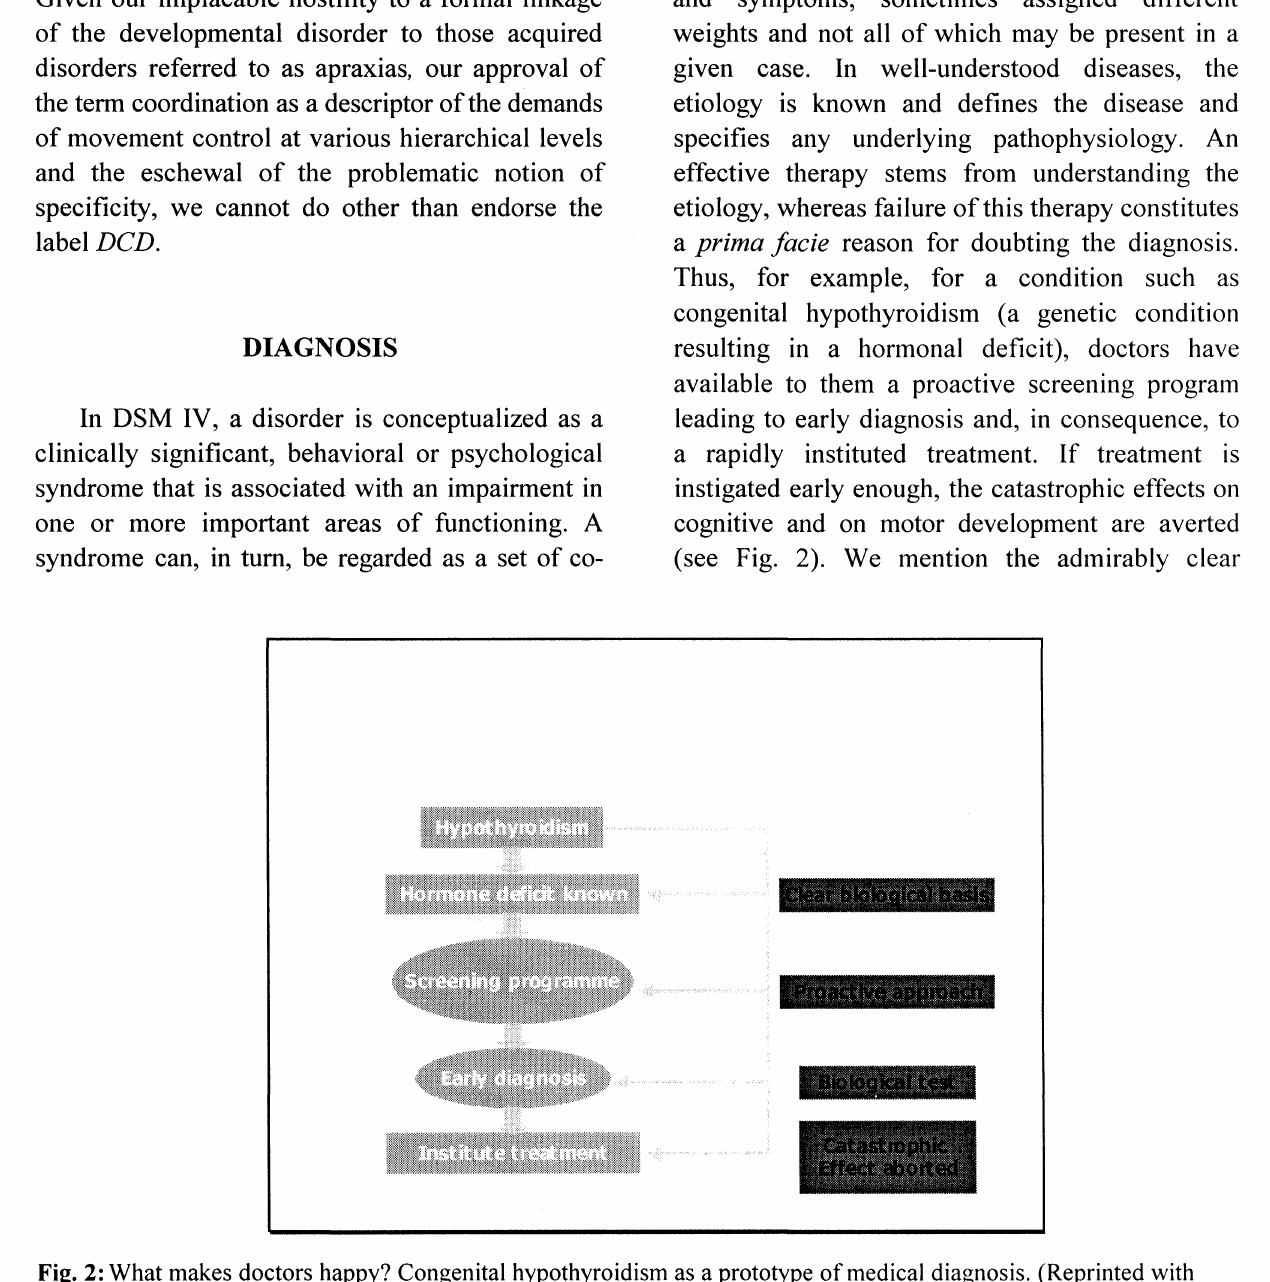
Fig. 2." What makes doctors happy? Congenital hypothyroidism as a prototype of medical diagnosis. (Reprinted with permission of Professor Hilary